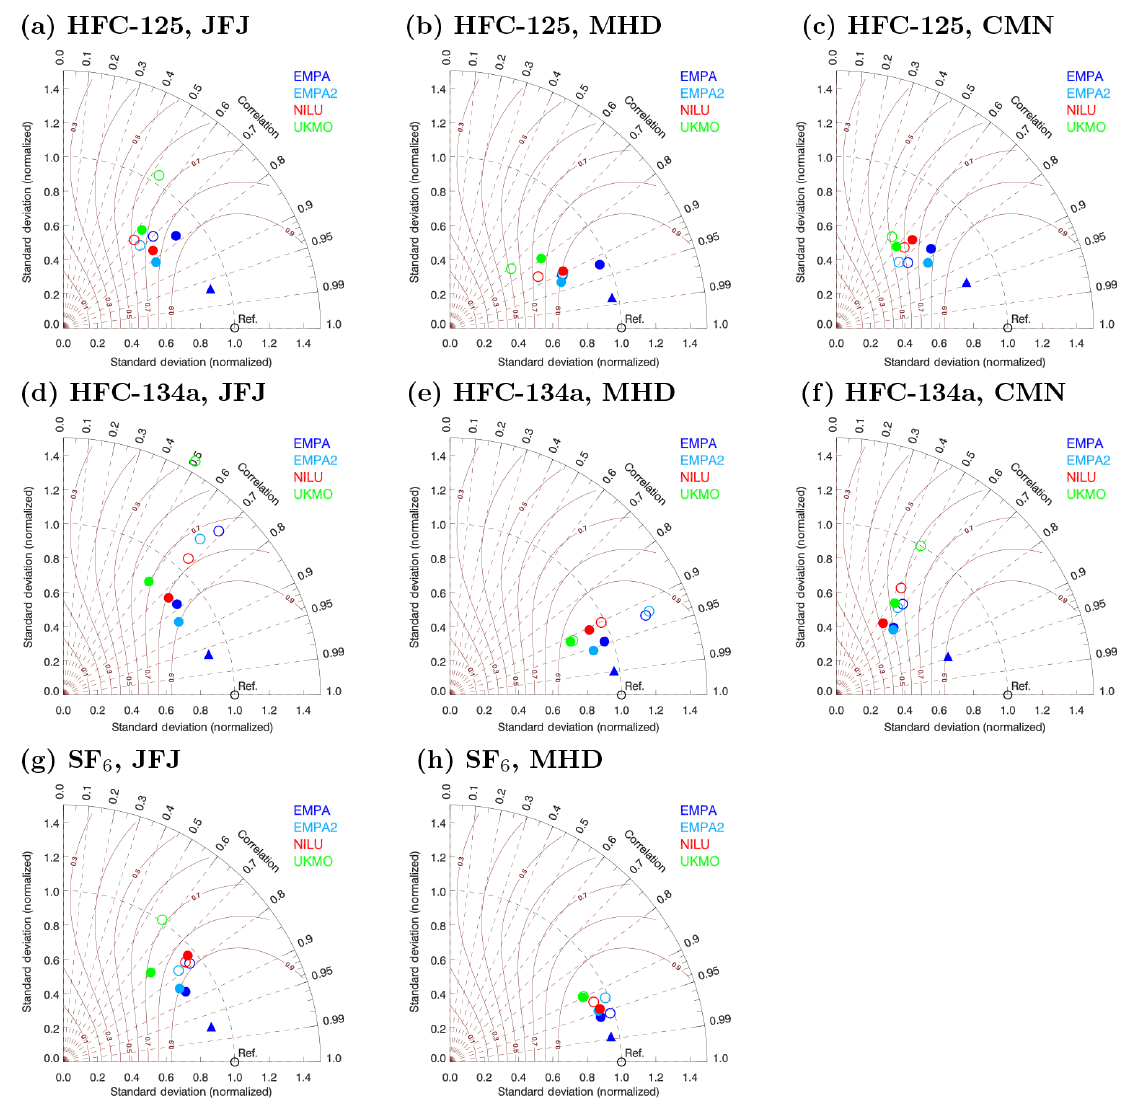
Figure 4. Taylor diagrams of model performance for the simulated prior (open circles) and posterior (filled circles) mole fraction time series. The filled blue triangle for EMPA indicates the performance when including an AR(1) autocorrelation term in the Kalman filter. The linear distance from the reference point (Ref.) is proportional to the centred (bias-corrected) root mean square error (RMSE). The angle of rotation with respect to the vertical axis corresponds to the Pearson correlation coefficient R